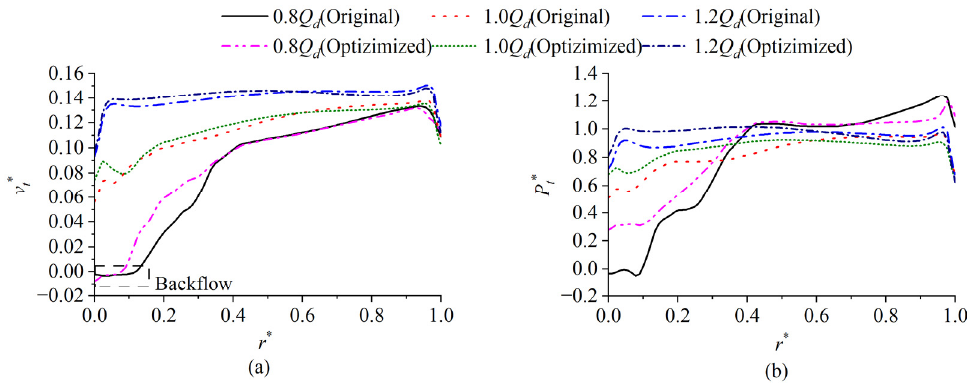
Figure 14. Comparison of the flow field at the impeller outlet: ( a ) axial velocity coefficient v t * , and ( b ) total pressure rise coefficient P t * .